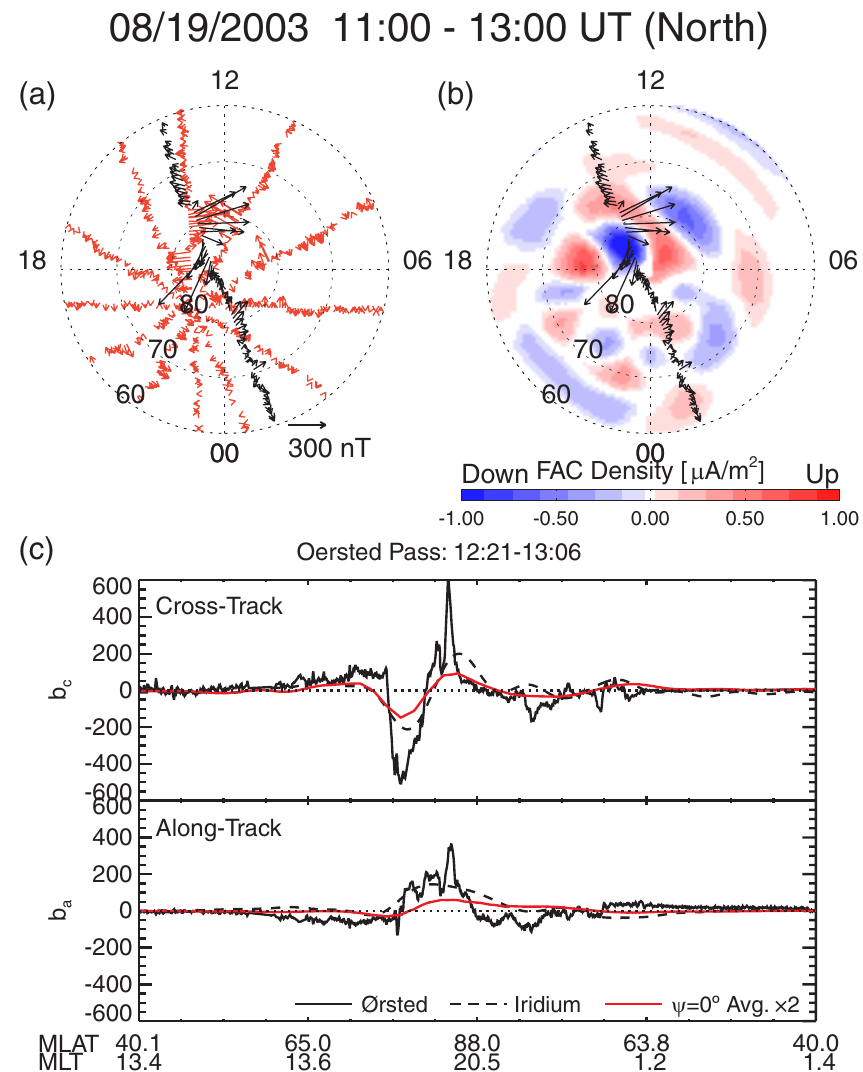
Fig. 6. Ørsted and Iridium observations for a northward IMF event from 19 August 2003. Iridium data are from 1100 to 1300 UT and Ørsted data are from the northern hemisphere pass from 1221 to 1306 UT. Figures show comparison of Ørsted horizontal magnetic field perturbations (black arrows and solid black traces) with (a) Iridium cross-track perturbations (red arrows), (b) Birkeland currents derived from Iridium data (red-blue color scale), and (c) Ørsted data (black trace), spherical harmonic fit vector horizontal field from Iridium (dashed trace), and twice the ψ = 0 ◦ statistical average (red line) evaluated along the Ørsted track. Ørsted data in panels (a) and (b) are shown as arrows starting at the Ørsted location. Panel (c) shows the horizontal components in cross, b c , (upper panel) and along, b a , (lower panel) track directions. Average solar wind and IMF conditions for this interval are given in Table